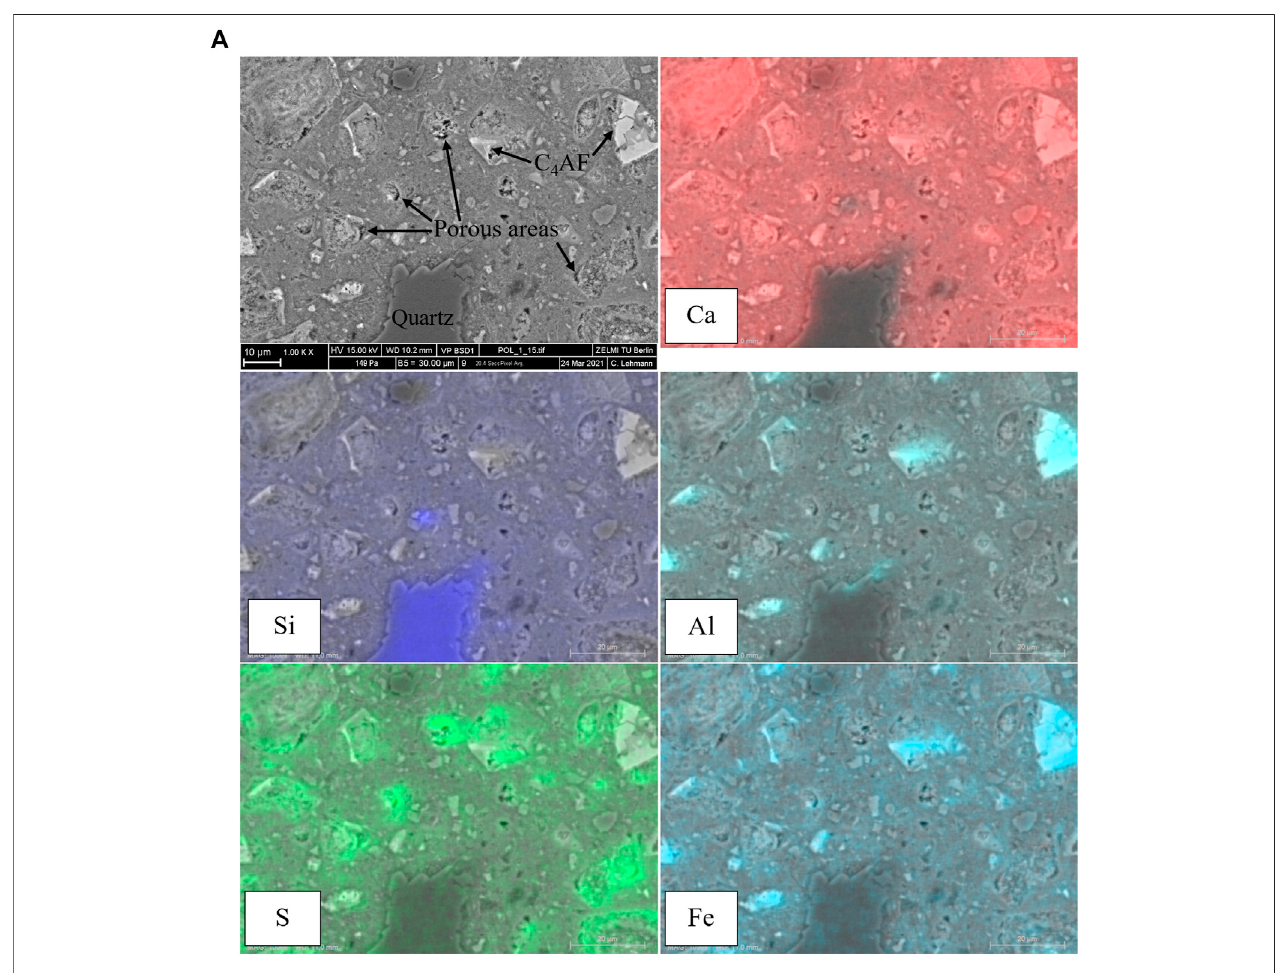
FIGURE 5 | Element mapping of the autoclaved C1 (A) and C2 (B)